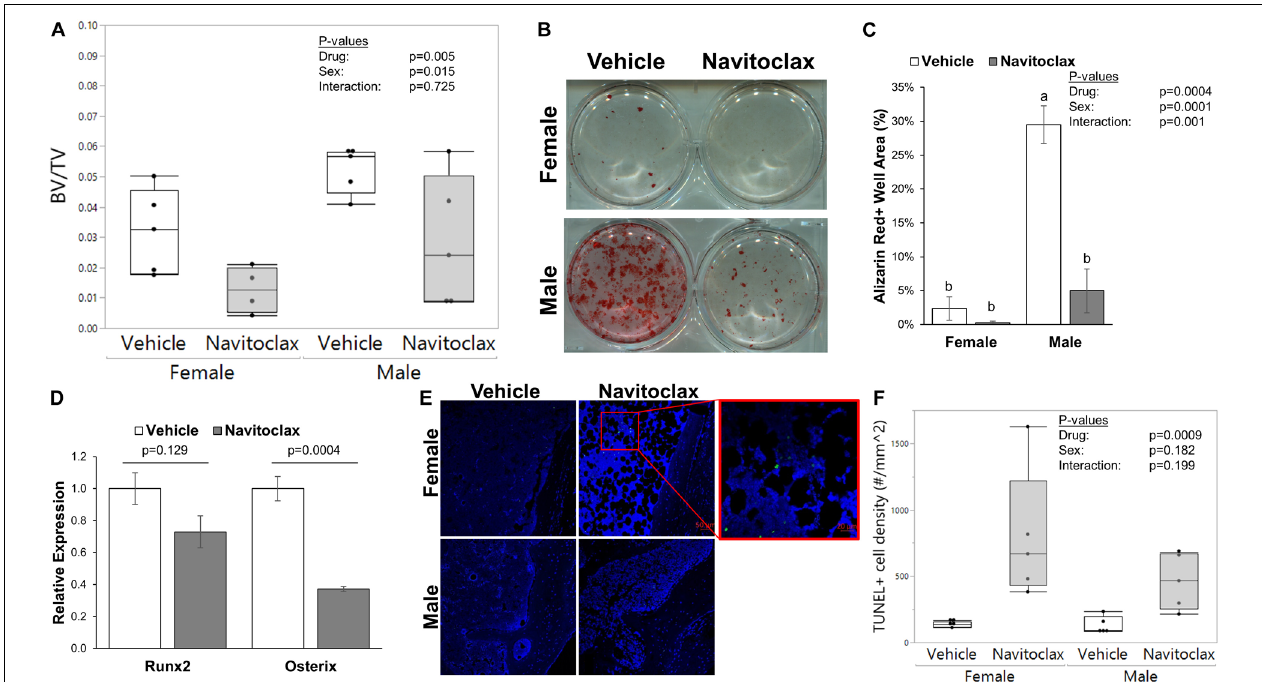
FIGURE 1 | Navitoclax administration caused trabecular bone loss and impaired osteoprogenitor differentiation. (A) Navitoclax (50 mg/kg body mass, once daily) was administered to 24 month-old male and female mice via oral gavage for 2 weeks. Trabecular bone volume fraction, measured histologically in the proximal tibia, was significantly decreased by navitoclax treatment. (B,C) Primary BMSC from the mice (A) were harvested at sacrifice and subjected to osteogenic culture conditions for 21 days. Cells from navitoclax-treated mice demonstrated reduced production of calcified matrix (C) . (D) BMSC were cultured under osteogenic conditions for 7 days; cells from navitoclax-treated mice demonstrated reduced expression of the osteoprogenitor gene Osterix/Sp7. (E,F) Frontal sections of the tibia from each mouse were stained with an in situ TUNEL detection kit to quantify apoptosis in the bone marrow; TUNEL+ cells were identified by green staining and normalized to tissue area. Original magnification: 200X; inset box shows the region magnified to 630X. Box plots show the median, quartiles, and outlier fences for each dataset, where outlier fences represent first quartile –1.5*(interquartile range) and third quartile +1.5*(interquartile range); each data point shown represents one mouse. P -values shown represent statistical comparisons between groups, p -value for “drug” in 2-factor ANOVAs represents the comparison between navitoclax (gray) and vehicle (white)-treated animals. A Tukey-Kramer HSD post hoc multiple comparisons test was performed when significant interactions were detected; bars with different superscript letters are significantly ( p < 0.05) different from one